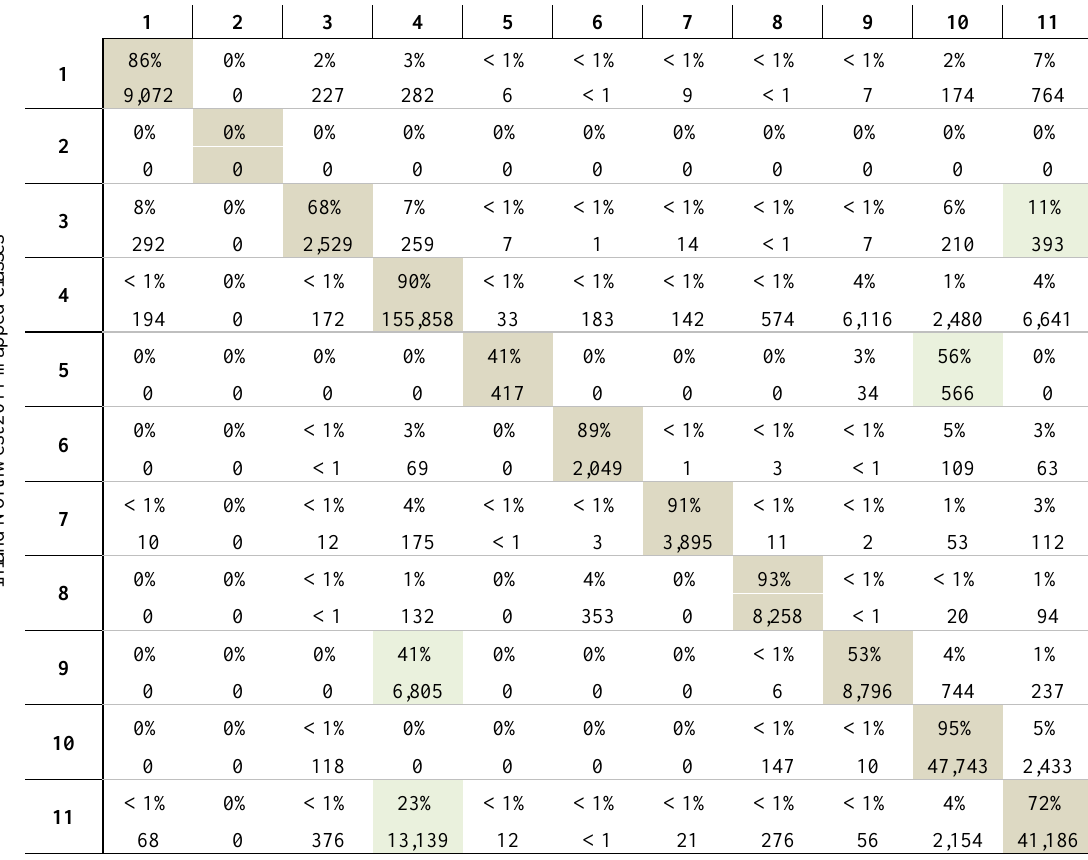
Table 2a. Percent and area (km 2 ) for each general land cover class in the 2001 and 2011 maps for the Inland Northweset geoarea. Codes correspond to the land cover classes in Table 1. Diagonals are highlighted for ease of reading, and off diagonals are highlighted where greater than 10% of the 2001 General Land Cover Class was different in